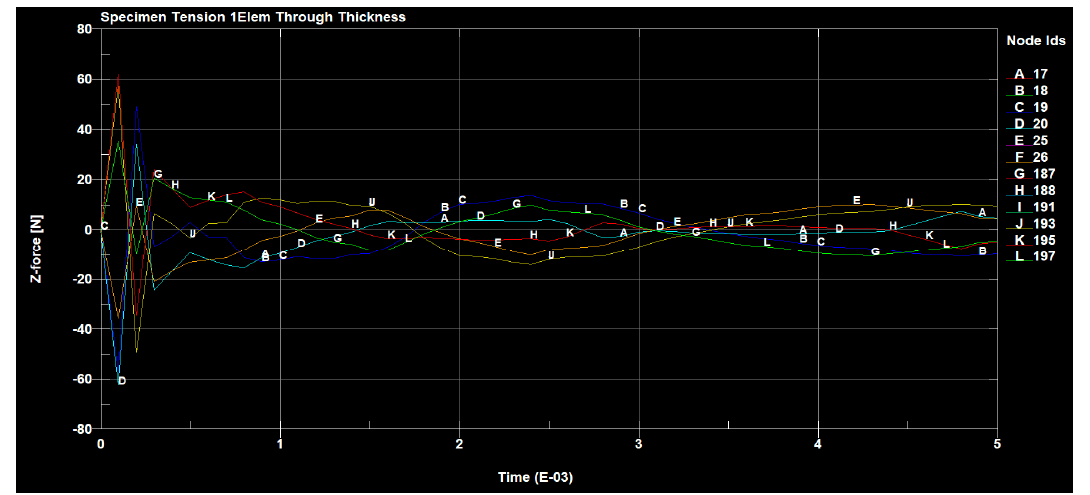
Figure 32. Tensile forces occurring on the sample in the 𝑧 direction.